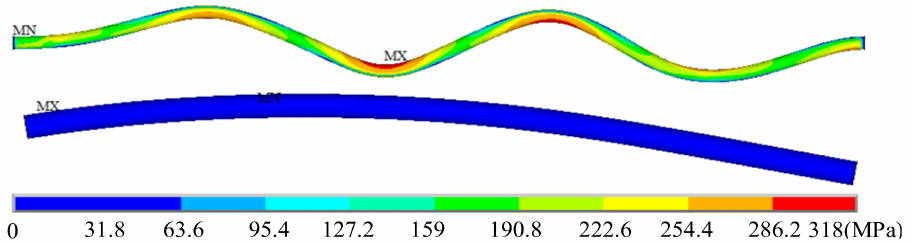
Figure 21. Stress distribution in reverse-contact